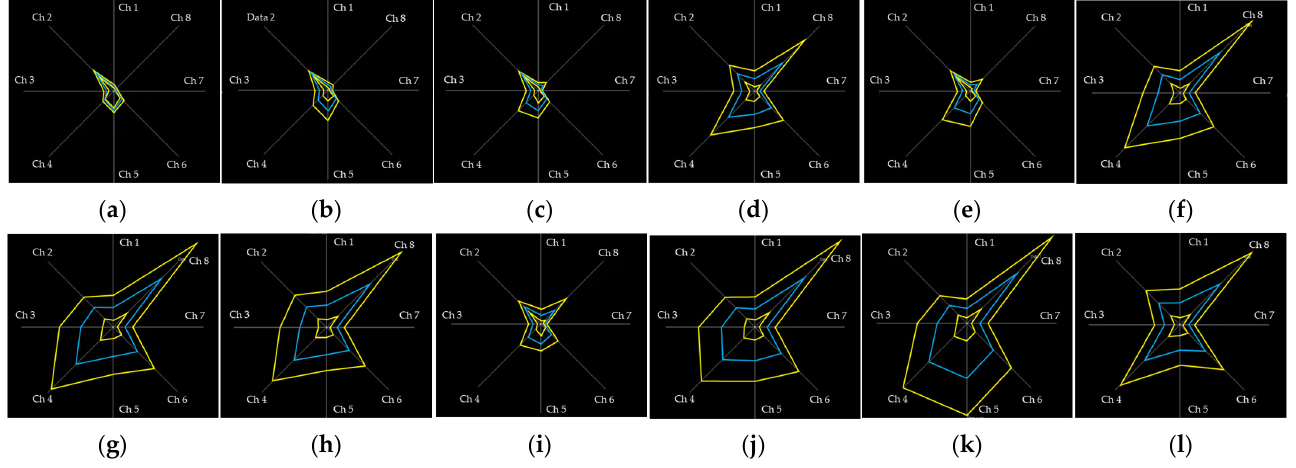
Figure 3. The radar plots of the forearm amputee on LabVIEW GUI: ( a ) rest, ( b ) spread, ( c ) finger pointing, ( d ) scissor sign, ( e ) V sign, ( f ) O.K. sign, ( g ) thumb up (hook), ( h ) cylindrical grasp, ( i ) spherical grasp, ( j ) lateral pinch, ( k ) palmar pinch, ( l ) tip pinch.